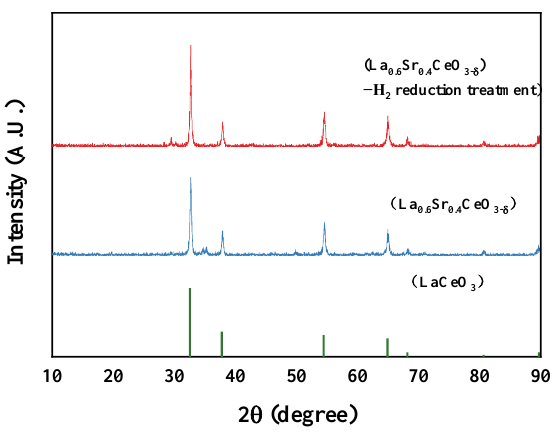
Figure 1. XRD pattern of La 0.6 Sr 0.4 CeO 3- δ catalysts before and after reduction by hydrogen.